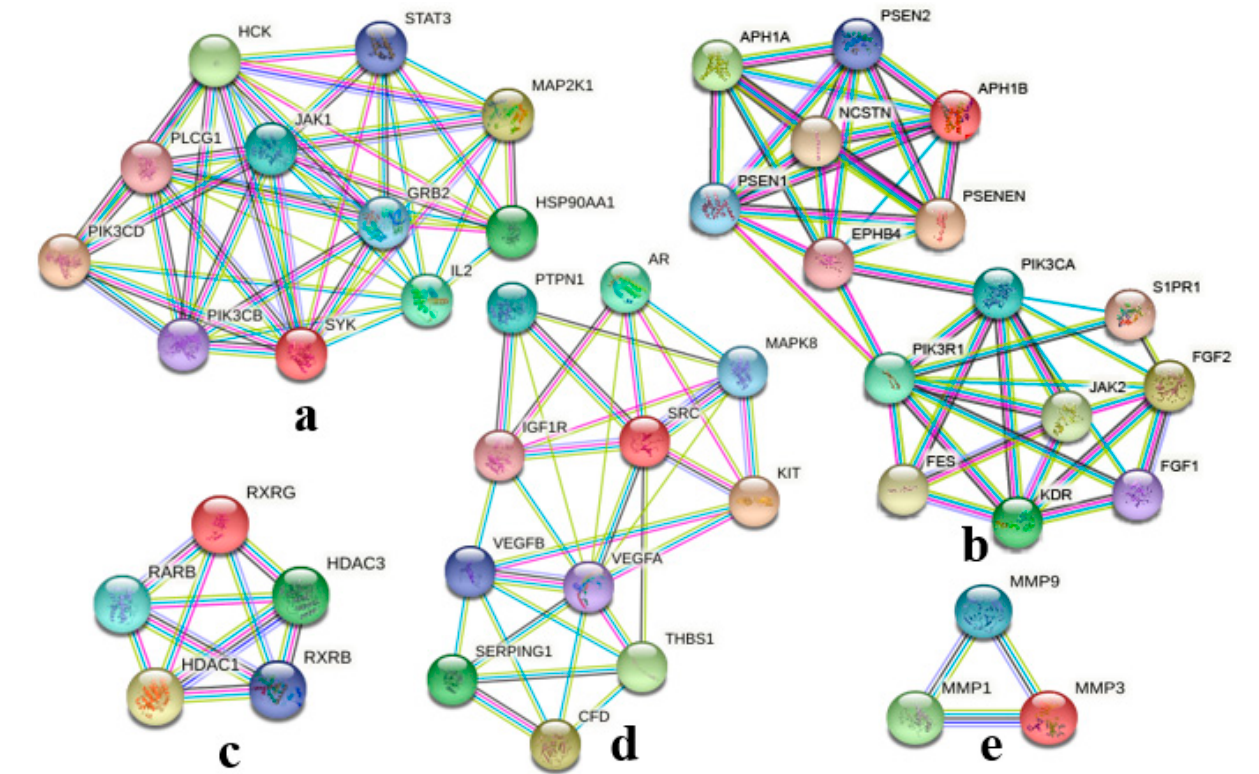
Figure 4. Central gene clusters identified in the GCK–osteoporosis PPI network based on MCODE analysis (( a ), ( b ), ( c ), ( d ), ( e ) was cluster 1, 2, 3, 4 and 5, respectively.). Colored lines represent the evidence which supports the interaction between different target proteins and the colored balls represent the different target proteins.